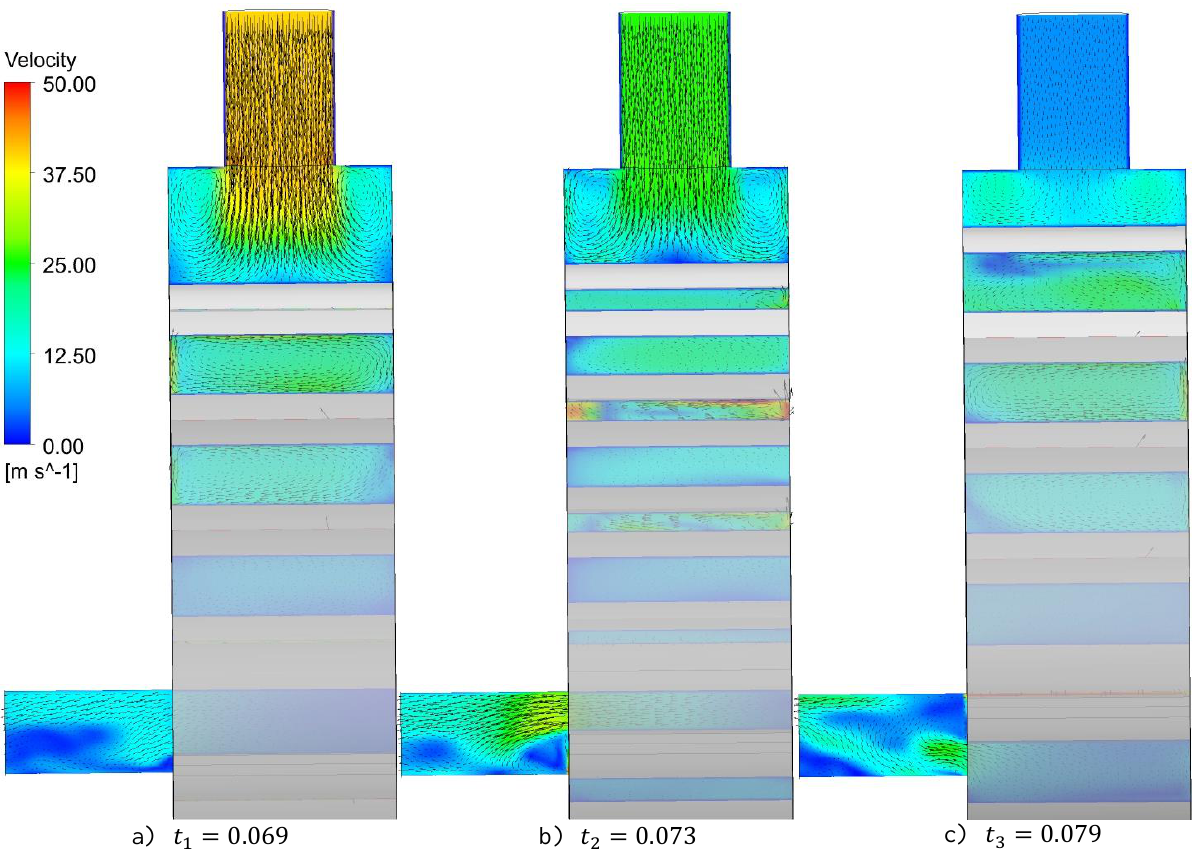
Figure 17. Vector plots of the flow field at mid-span for three different instants during the last revolution (CFX with axial gap).